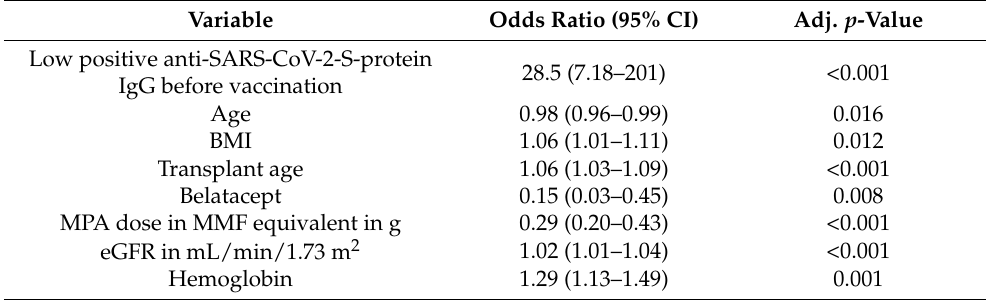
Figure 2. ( A ) Serological response rate ( ± standard deviation) per vaccination after basic immuniza- tion, three, four, and five doses of SARS-CoV-2 vaccines in kidney transplant recipients without sufficient serological response before the latest vaccination. ( B ) Cumulative serological response rate ( ± 95% confidence interval) after up to five doses of SARS-CoV-2 vaccines in all kidney transplant recipients with at least one vaccination meeting the inclusion and exclusion criteria. Table 3. Predictors of serological response after three doses of SARS-CoV-2 vaccines identified in mul- tivariable analysis. Adjusted (adj.) p -value according to Holm’s correction for multiple comparisons.